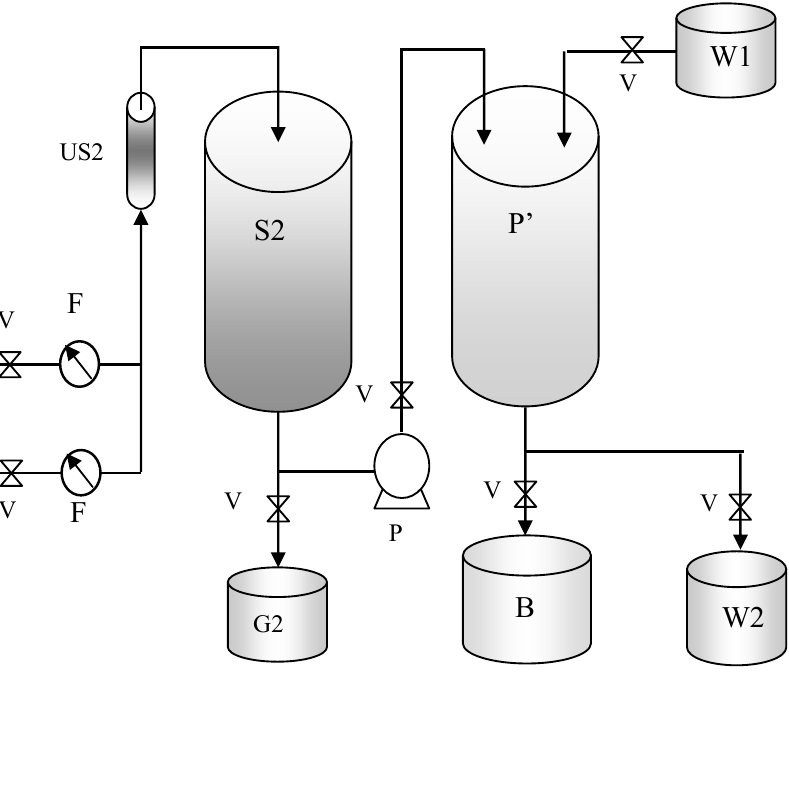
Figure 3. Flow diagram of an ultrasound-assisted continuous reactor for biodiesel production through a two-step process on the pilot